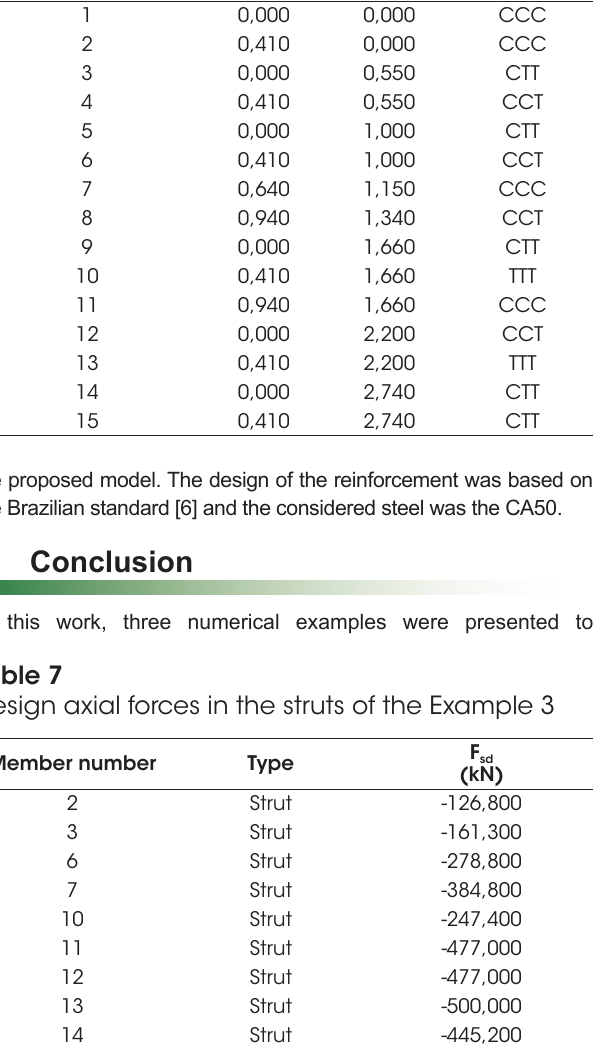
Identification of nodes of the Example 3 Node number